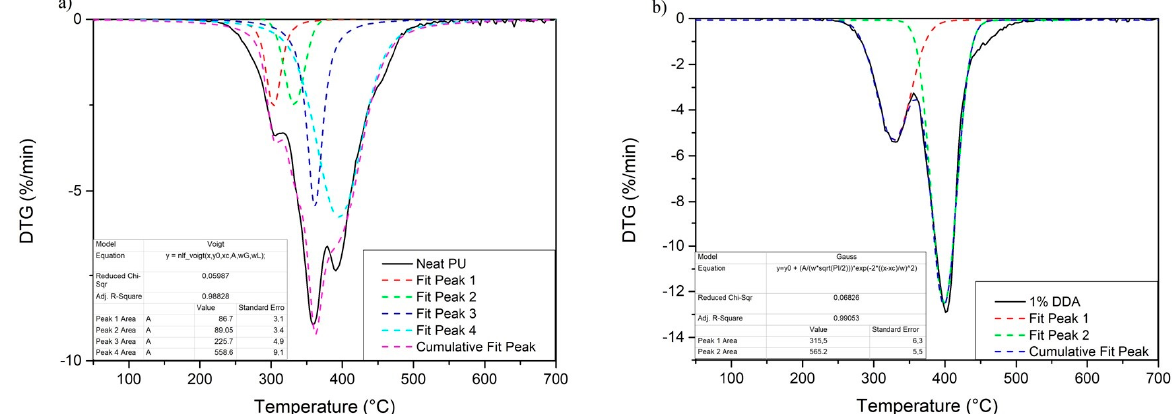
Figure 4. Deconvolution of DTG curves of neat PU and 1% DDA nanocomposite. ( a ) Neat PU; ( b ) 1% DDA sample.